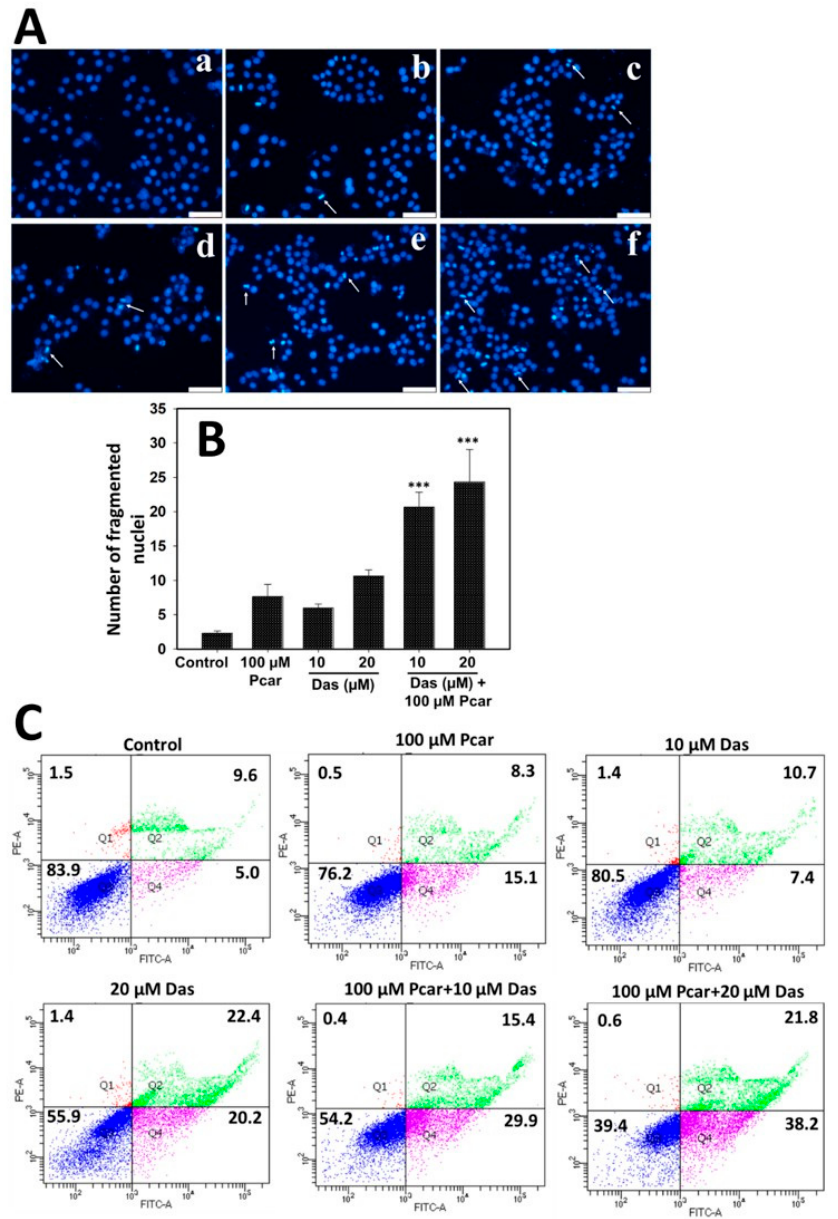
Figure 3. Nuclear fragmentation and apoptosis in groups treated with Pcar and Das both alone and in combination were determined by DAPI and annexin V/PI staining, respectively. ( A ) Fluorescence microscopy showed that Pcar and Das in combination induce nuclear fragmentation (white arrows) in HepG2 cells. ( a ) Control; ( b ) 100 µ M Pcar; ( c , d ) 10 and 20 µ M Das; ( e , f ) 100 µ M Pcar + 10 and 20 µ M Das ( B ) Quantitative analysis was performed by analyzing 3 independent microscopic areas in each group. ( C ) Flow cytometric analysis of annexin V/FITC-stained cells showing that Pcar and Das combination therapy induces apoptotic induction in HepG2 cells. Data represented as mean ± standard error (SE) obtained from three ( n = 3) independent experiments, *** p < 0.001. Scale bar 100 µ